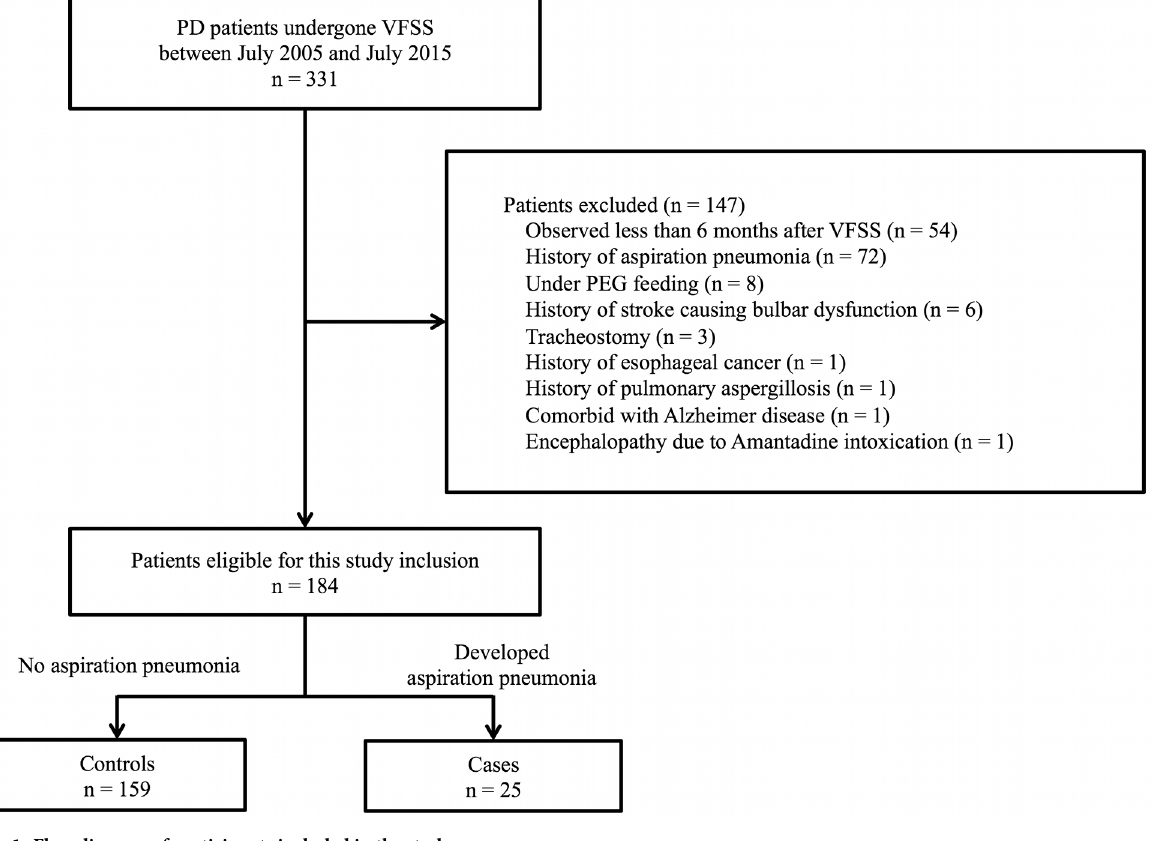
Fig 1. Flow diagram of participants included in the